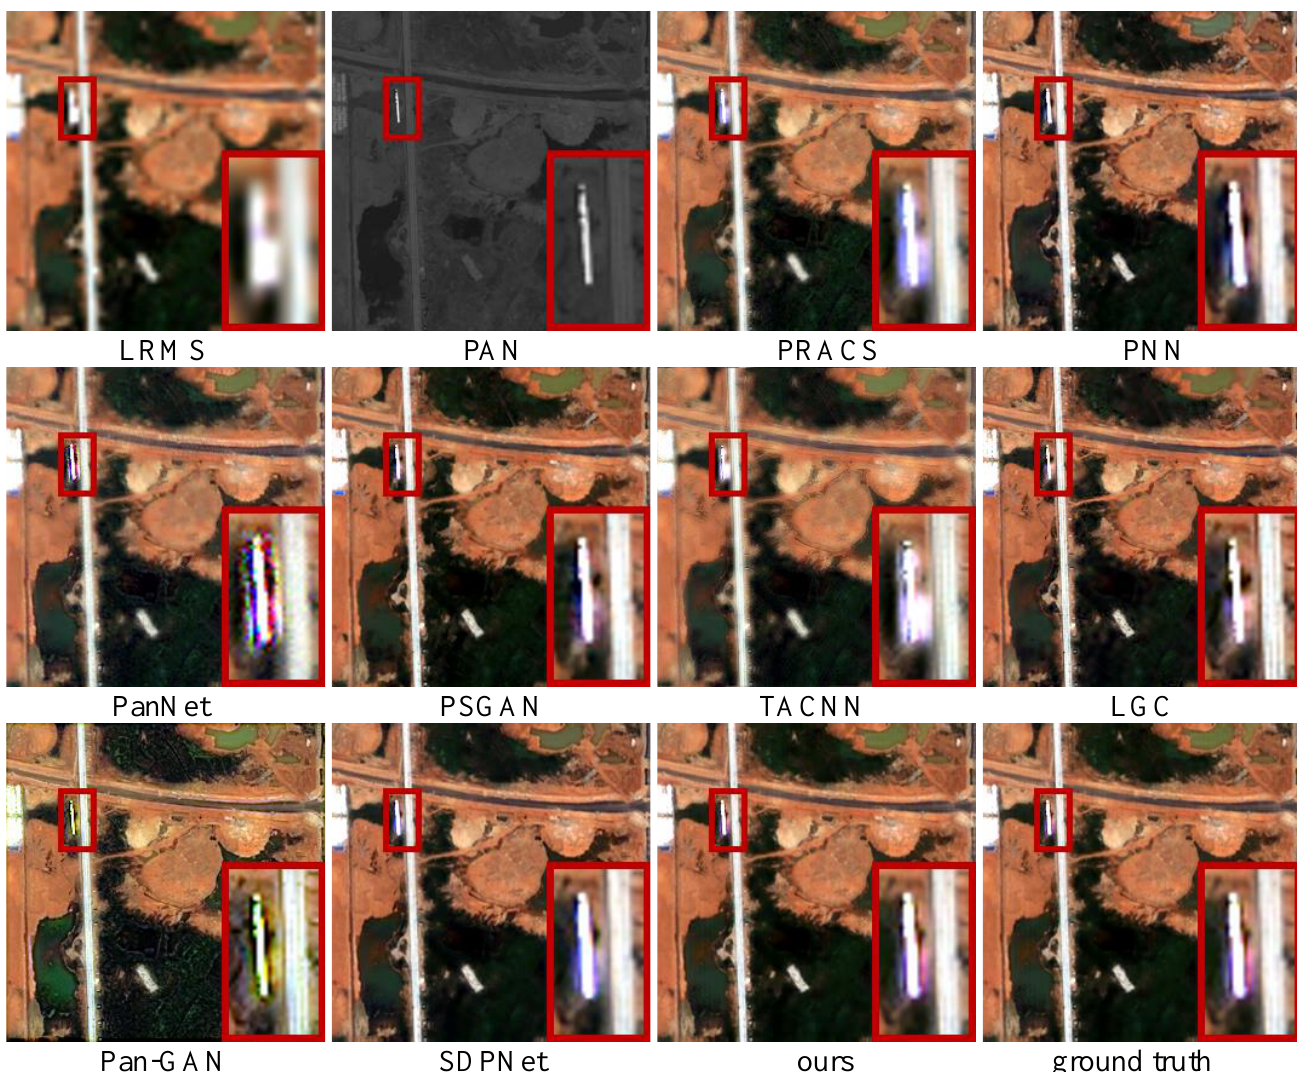
Figure 4. Qualitative comparison of CPNet with other eight pan-sharpening methods on the data from the QuickBird data set. The first row: the LRMS image, the PAN image, the results of PRACS and PNN; the second row: the results of PanNet, PSGAN, TACNN, and LGC; the third row: the results of Pan-GAN, SDPNet, and our CPNet, and the ground truth. In the reduced validation, the PAN images are of size 264 × 264 and the LRMS images are of size 66 × 66 × 4. The fused HRMS results are of size 264 × 264 ×